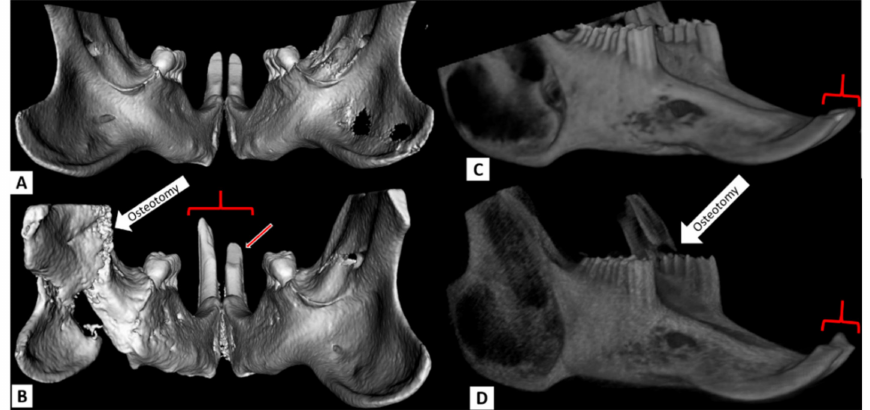
Figure 7. Reconstructed µ CT & CBCT images of rat and rabbit mandibles with left side wide gap CROs: ( A ) Baseline rat image. ( B ) The rat mandible with the defect unhealed after the 3-week study conclusion: note the left incisor is considerably longer and dysmorphic with no recognizable occlusal surface morphology (brackets). The right incisor is slightly altered relative to baseline (arrow) but retains some of its occlusal surface morphology and length as the rat continued to masticate and gnaw on that side. ( C ) Baseline rabbit mandible image. ( D ) The rabbit mandible 3 weeks following CRO (arrow): Note the tooth ipsilateral to the defect is longer and the occlusal surface grossly altered relative to the right incisor (brackets). µ CT = micro computed tomography, CBCT: cone beam computed tomography, CRO = complete ramus